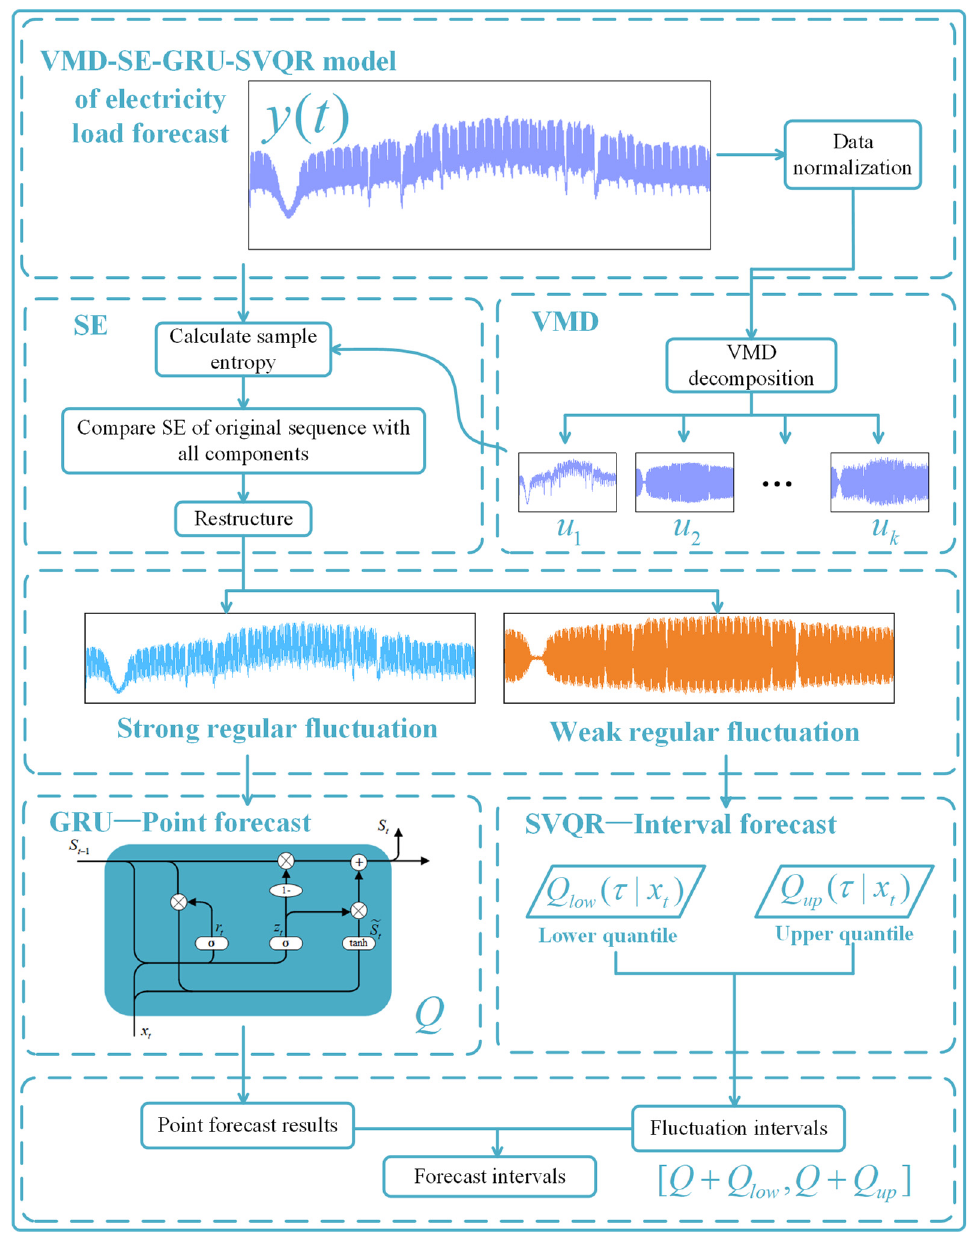
Figure 2. Process diagram of the proposed model.